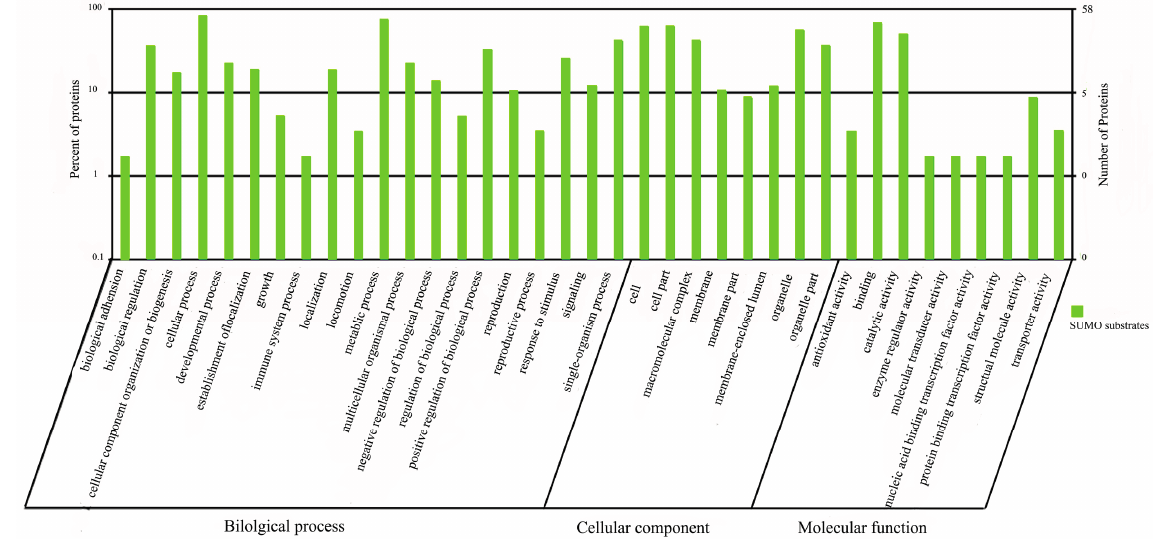
Figure 4. Gene ontology (GO) categories of SUMO-conjugated proteins. Proteins were classified into Biol. process, cellular component, and molecular function categories by Web Gene Ontology Annotation Plot (WEGO), according to the GO hierarchy. The number of proteins mapped to the GO terms is shown on the right axis. The left axis shows the proportion of total proteins mapped to the GO